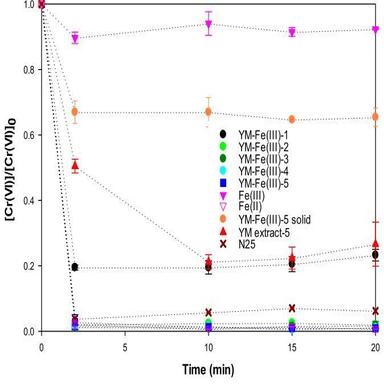
Temporal evolution of the normalized Cr(VI) concentration after 20 min of contact with different YM-Fe(III)-X suspensions and controls at Cr(VI):Fe MR = 1:3, and with the YM extract-5. Conditions: 0 = 300 μM, pH 3.